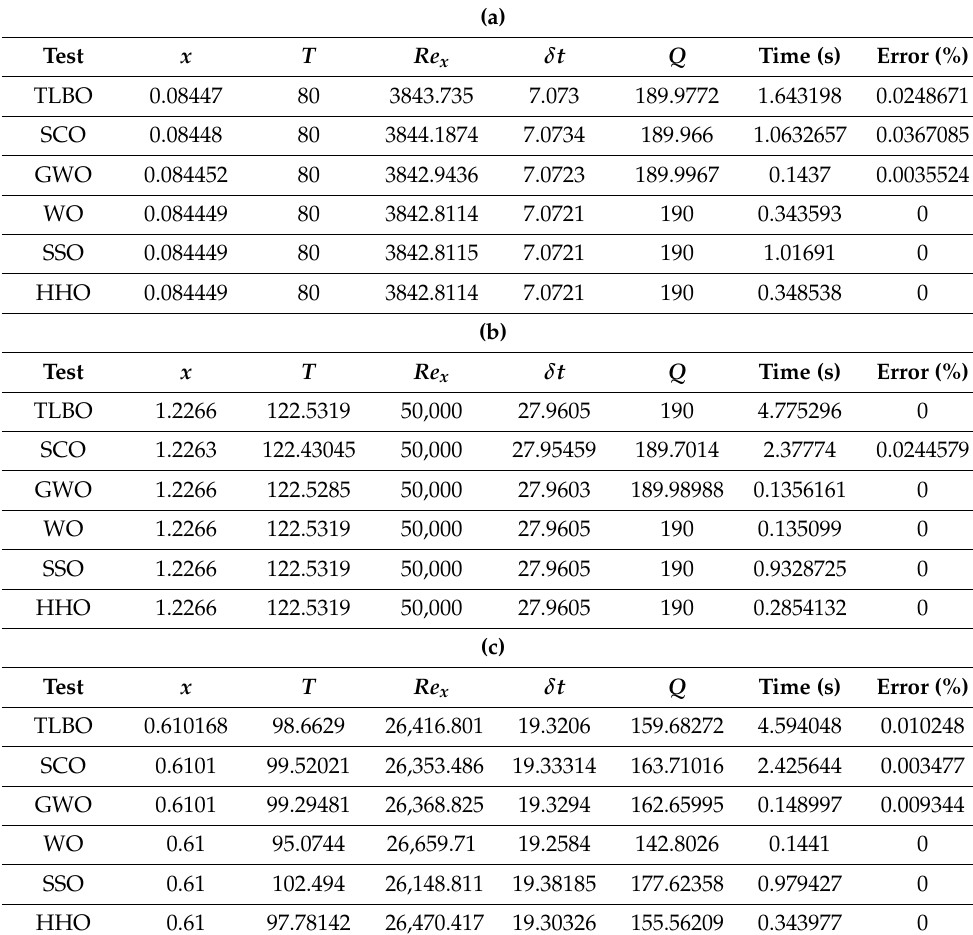
Table 2. Case 1 optimization results, ( a ) x Minimum value, ( b ) x Maximum value, ( c ) x Target value (0.61